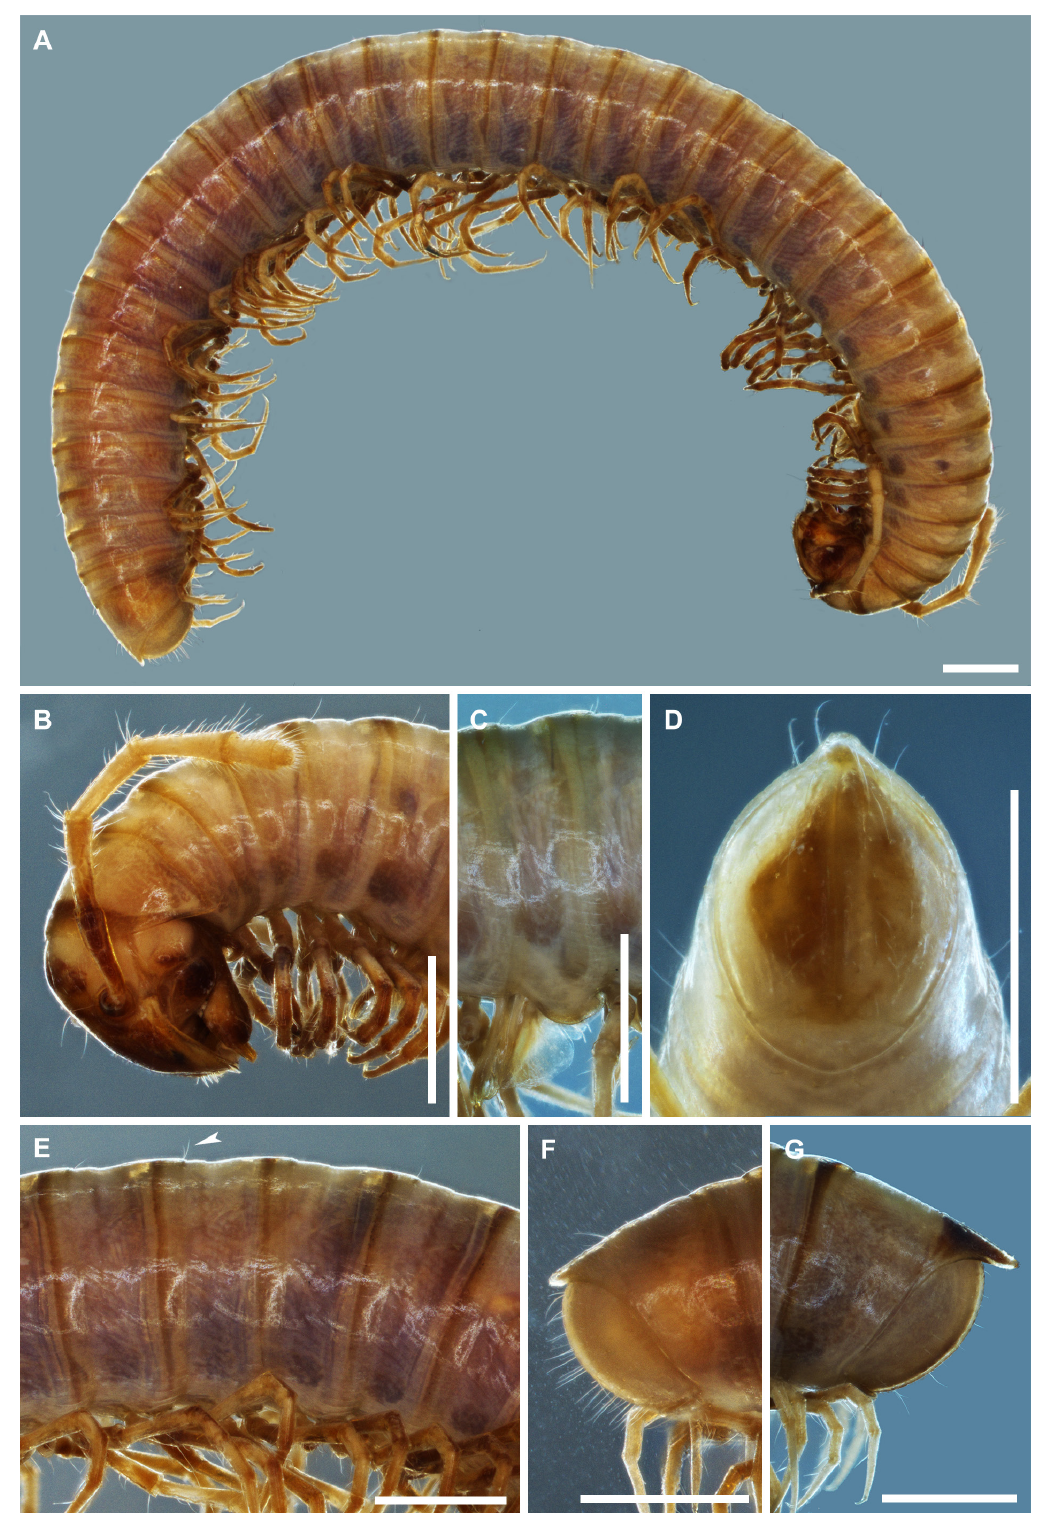
Fig. 44. Leucogeorgia redivivoides sp. nov., types from Nizhnyaya Shakuranskaya Cave (ZMUM) (A– C, E–F: holotype ♂; D: paratype ♂; G: paratype ♀). A . Habitus, lateral view. B . Anterior part of body, lateral view. C . Body ring 7, lateral view. D . Telson, posterior view. E . Midbody rings, lateral view. F . Telson, lateral view. G . Telson, lateral view. Arrow indicates metazonal setae. Scale bars: 1